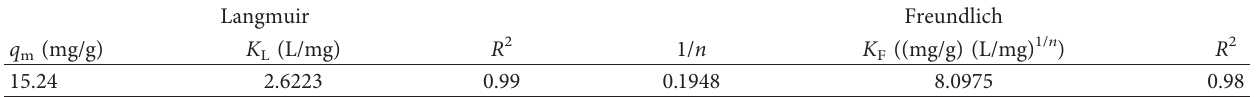
Table 2: Langmuir and Freundlich isotherm parameters (adsorbent dose � 16g/L; pH � 7.21; T � 22 ° C). Langmuir